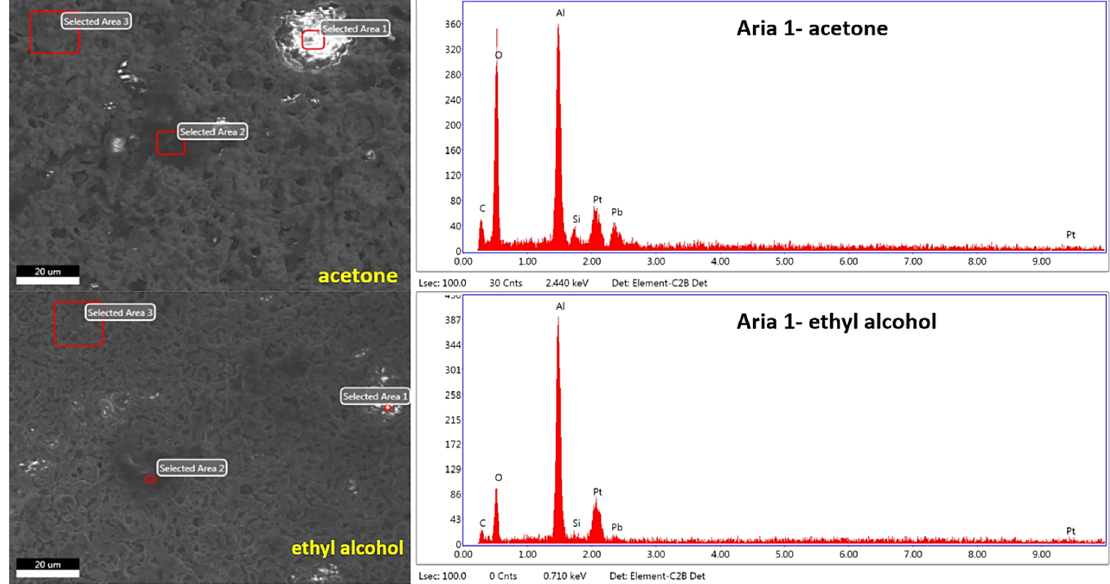
Figure 13. SEM/EDX for the platinum electrodes treated with acetone and ethanol